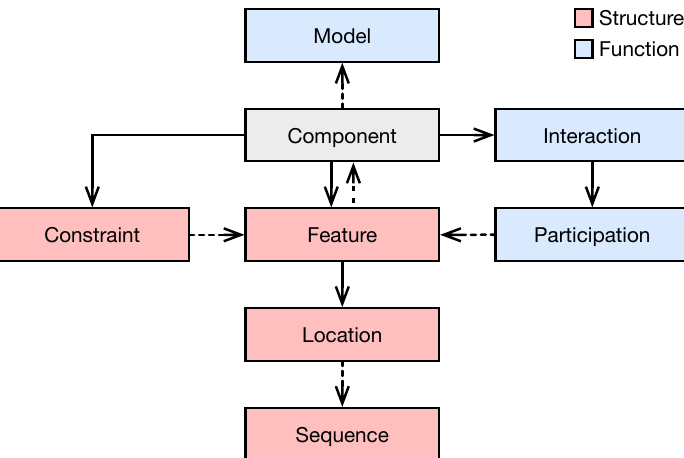
Figure 2: The SBOL Component object and related objects. Solid arrows indicates ownership, whereas a dashed arrow represents a reference to an object of another class. Red boxes represent structural objects, while blue boxes represent functional objects. To represent structural aspects, a Component can include Feature s, which may refer to Location s within a Sequence . A Component can also include Constraint s between these features. To